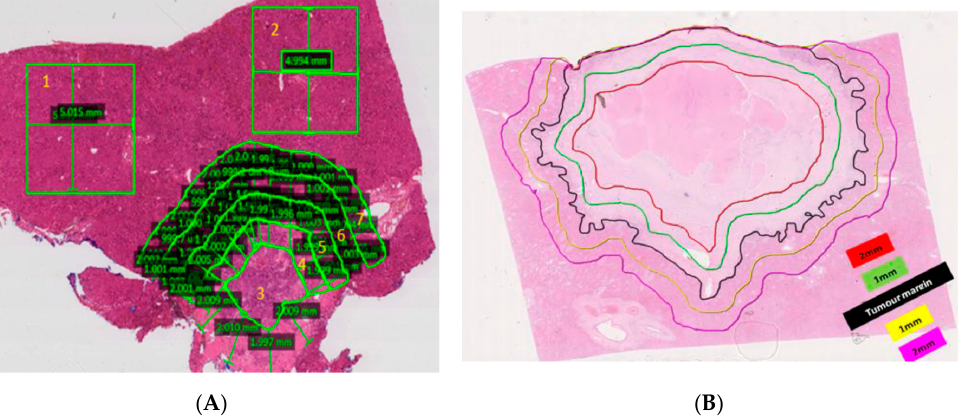
Figure 1. Example of zonal analysis on histopathology. ( A ) Method that was developed for calculation of microsphere deposition density. 1 and 2 = non-neoplastic tissue (NNT), 3 = Tumour centre, 4 = 1–2 mm zone within tumour border, 5 = 0–1 mm zone within tumour border, 6 = 0–1 mm zone away from tumour border, 7 = 1–2 mm zone away from tumour border. Slide magnification = 0.3 × . ( B ) Illustration of the 1 mm and 2 mm zones from the tumour margin that microsphere densities were measured within. The highest density was found within 1 mm from the tumour